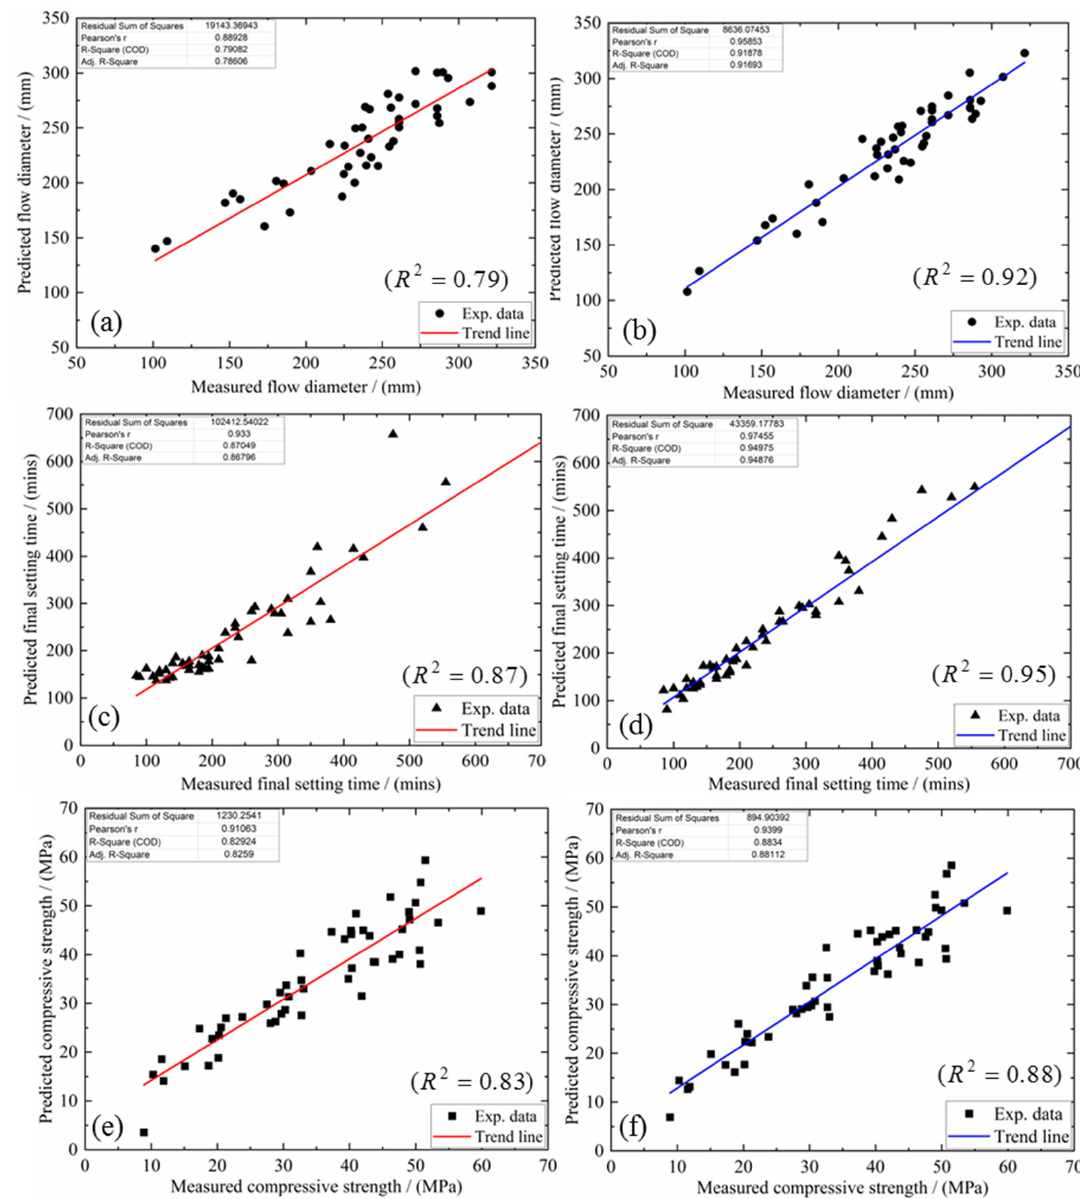
Figure 12. Comparing predicted results with actual observations for ( a , b ) flow diameter, ( c , d ) final set and ( e , f ) compressive strength.